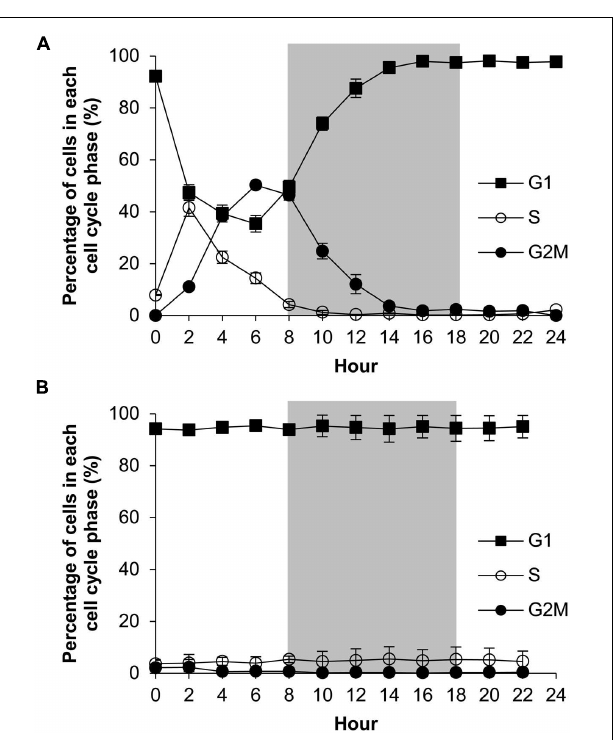
FIGURE 4 | Diel cell cycle profiles of A. carterae in the P-replete group (A) and P-deprived group (B). Gray shading indicates dark period. Shown are means ± standard deviations (error bars) from the triplicated